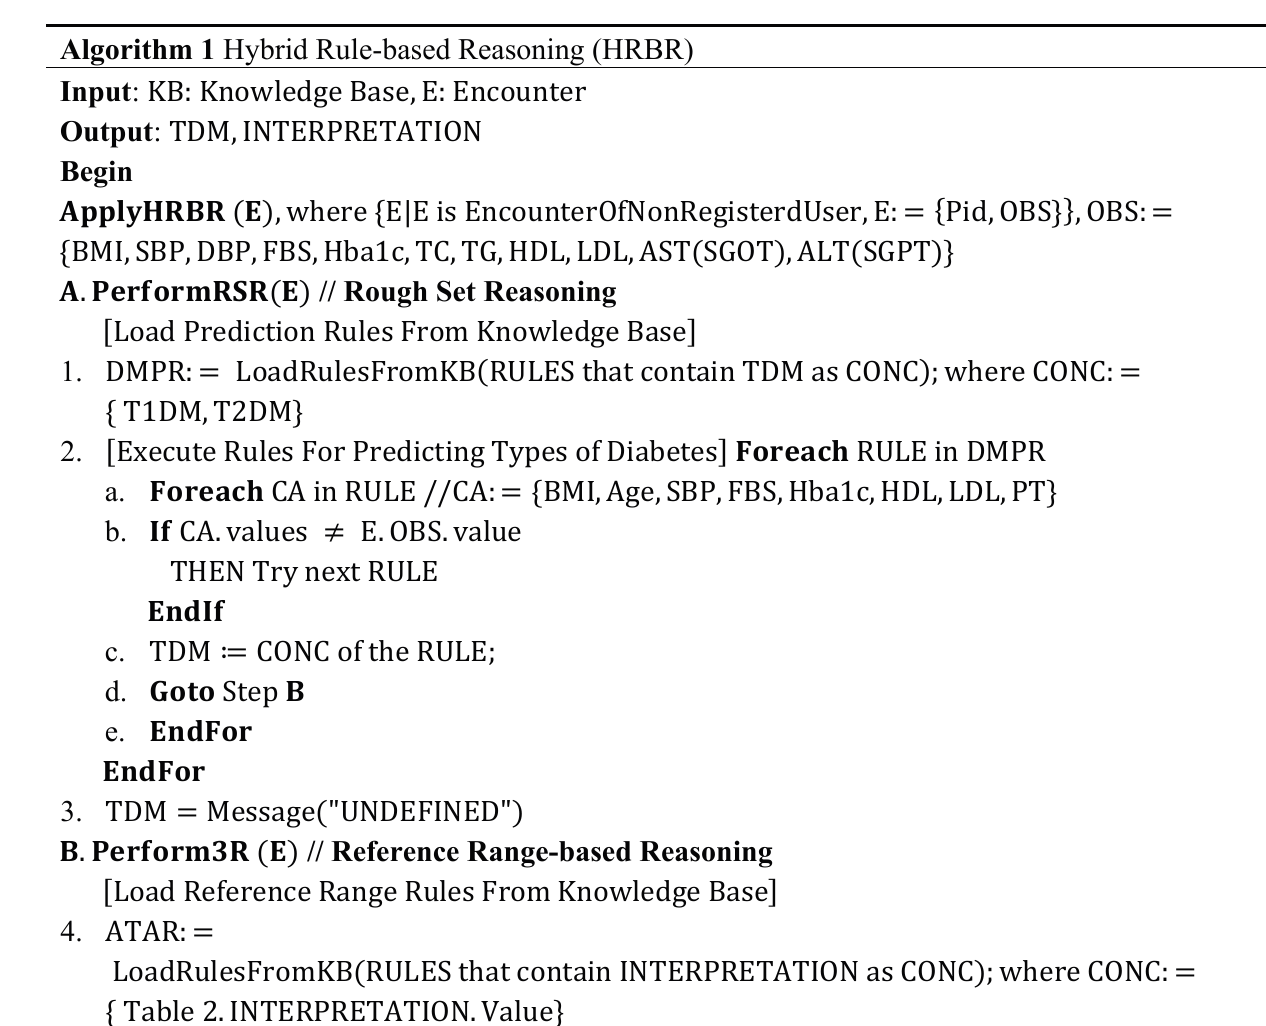
{ Table 2. INTERPRETATION.